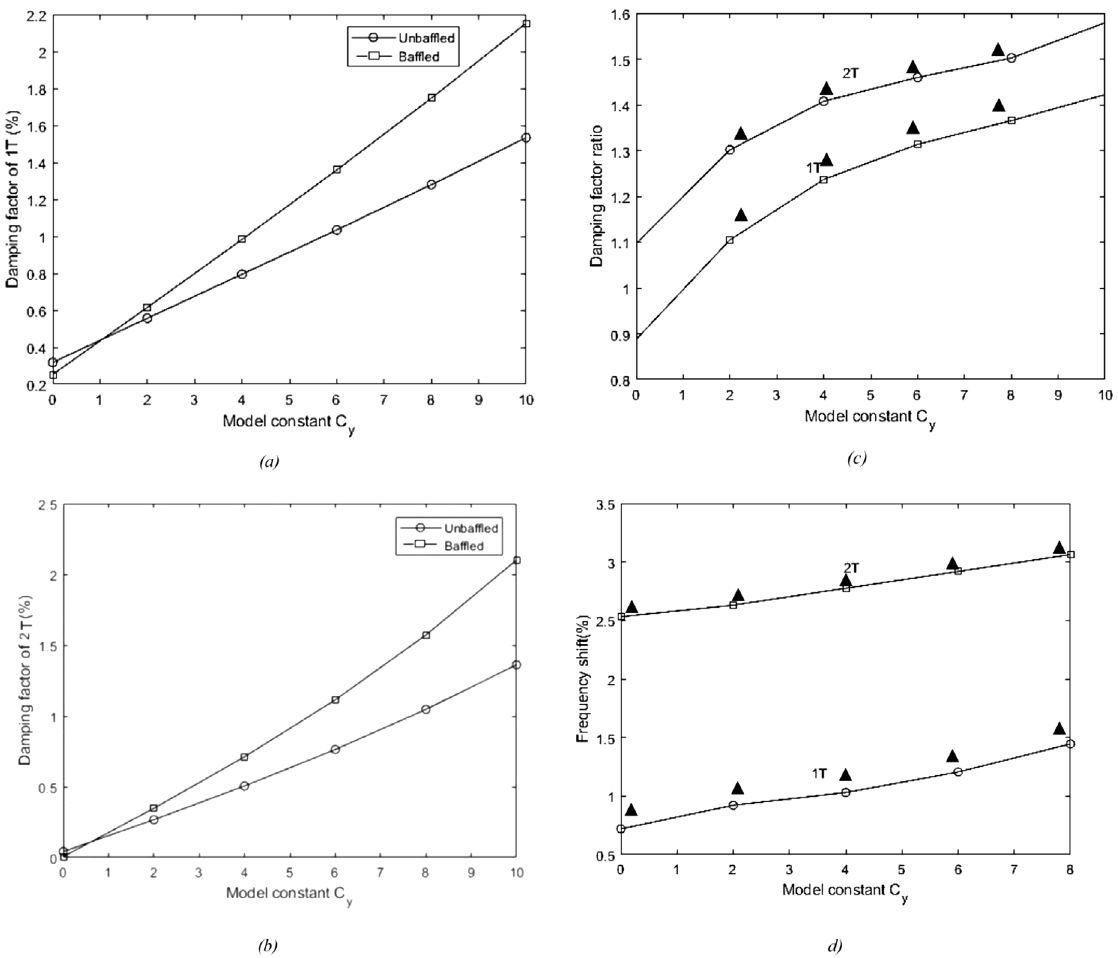
Figure 6. The effect of C y (model constant) on acoustic characteristics: Damping factor ratio in terms of C y around: (a) 1T mode, (b) 2T mode, (c) damping factor ratio around the fi rst, second tangent modes in terms of C y and (d) frequency shift versus C y